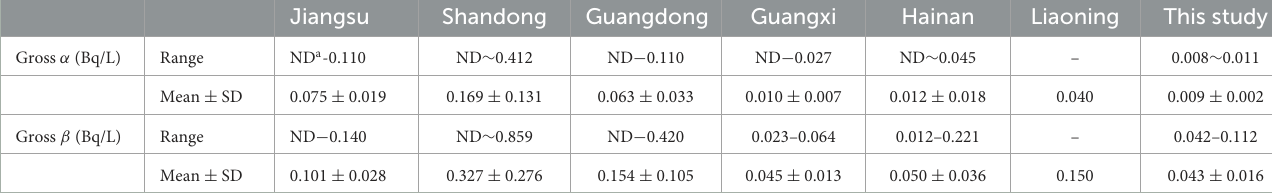
TABLE 3 Comparison of the radioactivity of gross α and gross β in tap waters of this study and other studies from different provinces in China (30).